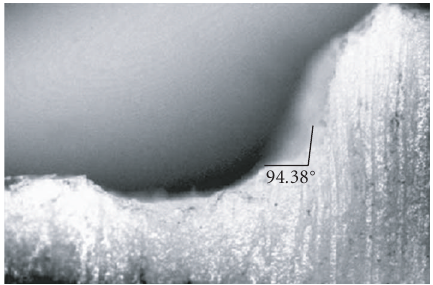
Figure 1: Image on profile projector for Group A.